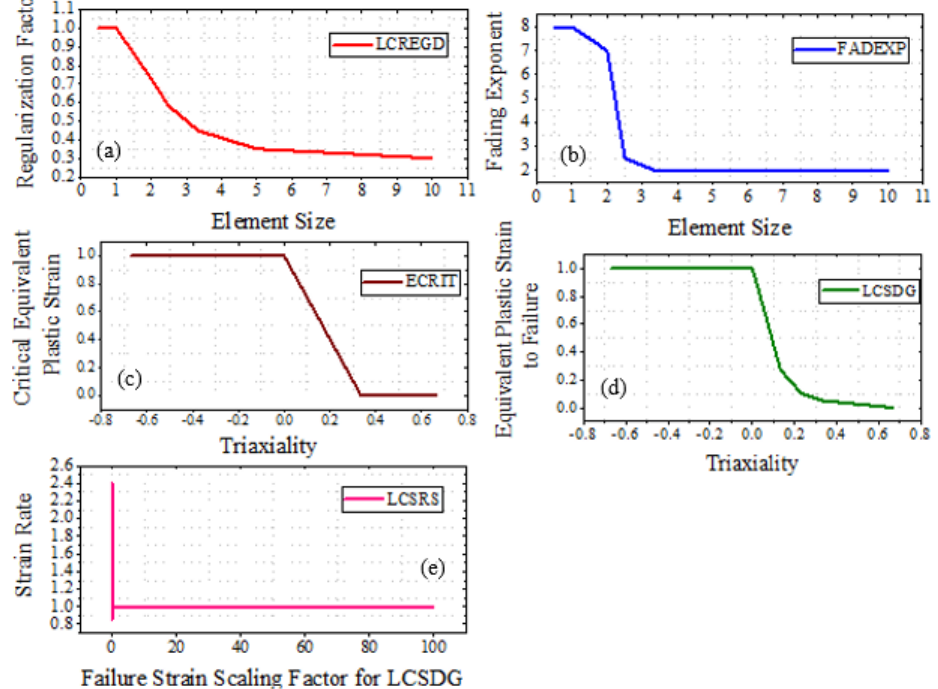
Figure 4. Figure 4. Input curves utilized for the Generalized Incremental Stress-State MOdel (GISSMO) damage Model; (a) LCREGD-Load curve defining element size dependent regularization factors for equivalent plastic strain to failure, (b) FADEXP-Load curve defining element-size dependent fading exponent, (c) ECRIT-Load curve defining critical equivalent plastic strain versus triaxiality, (d) LCSDG-Load curve for equivalent plastic strain to failure vs. triaxiality, (e) LCSRS-Load curve defining failure strain scaling factor for LCSDG vs. strain rate.